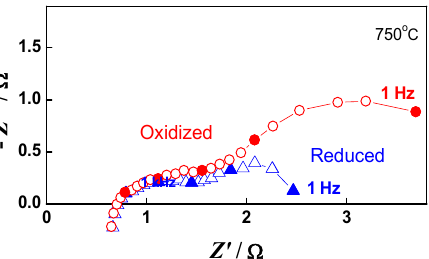
Figure 11. Impedance diagrams of button cell measured during the 20th redox cycle: Oxidized state ( ○ ); Reduced state ( ∆ ).